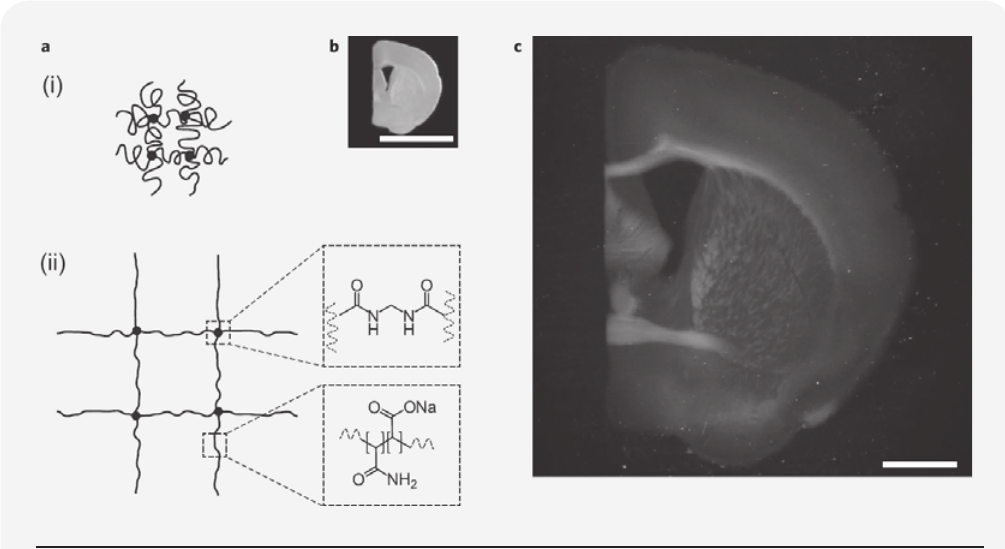
Figure 7. Concept and example of expansion microscopy. (a) Schematic of (i), collapsed polyelectrolyte network, showing crosslinker (dot) and polymer chain (line), and (ii) expanded network after H 2 O dialysis. (b) Photograph of fi xed mouse brain slice. (c) Photograph, post-ExM, of the sample (b) under side illumination. Adapted from Ref. 23.